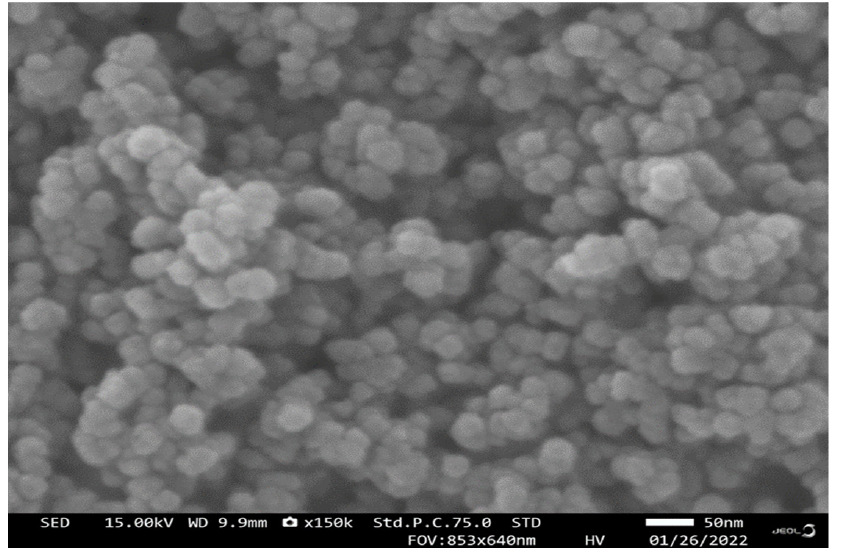
Figure 1. Scanning electron micrographs (SEM) of CuO NPs synthesized by wet chemical reaction, Figure 1 . Scanning electron micrographs ( SEM ) of CuO NPs synthesized by wet chemical reaction, scale 50 nm. scale 50 nm .